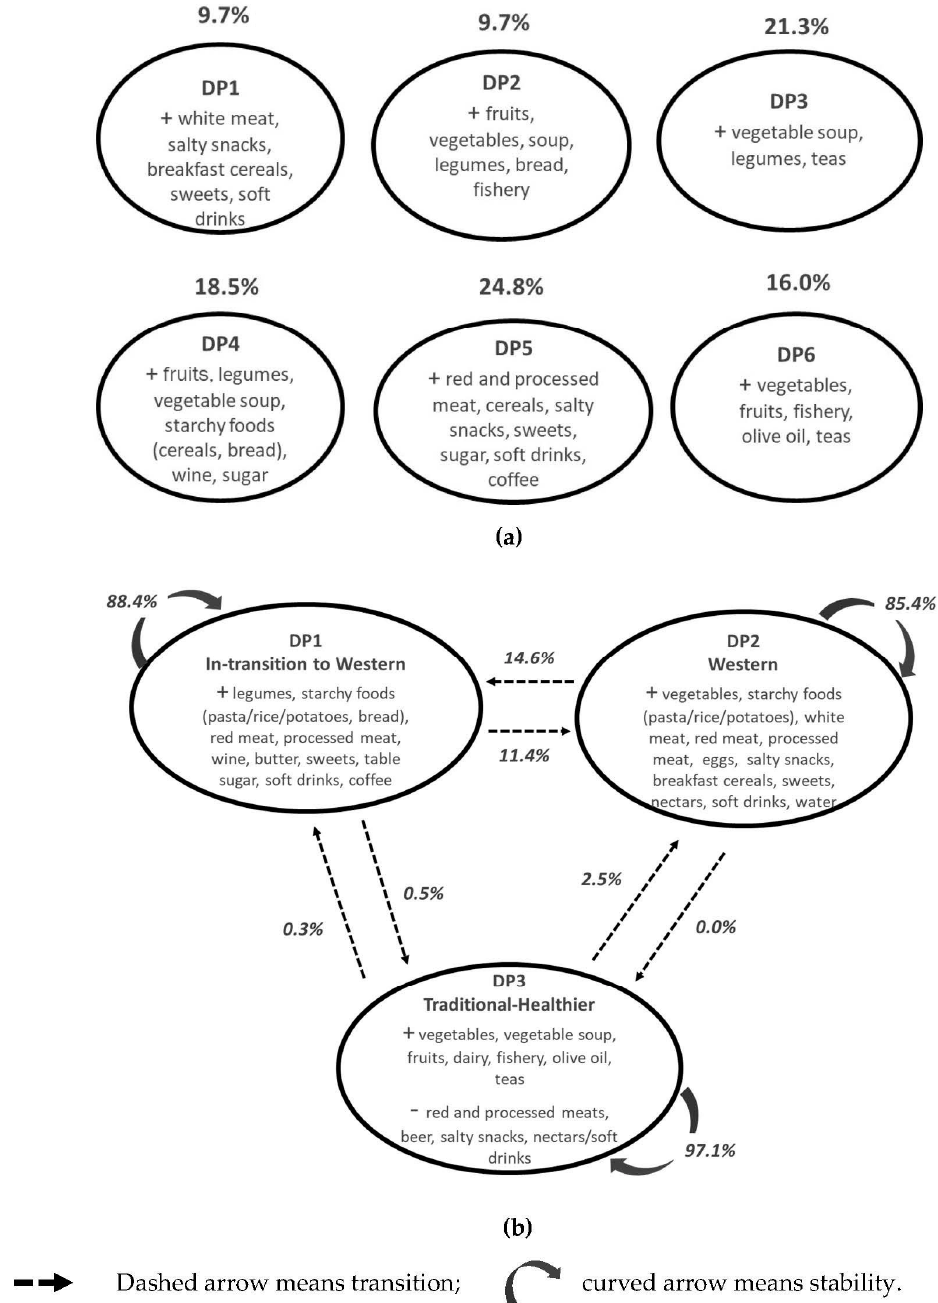
Figure 1. Description of dietary patterns: ( a ) latent class model (with concomitant variables); ( b ) latent transition model (with concomitant variables). Percentages (%) are the latent class probabilities (1a) or the latent transition probabilities (1b) based on the estimated model; food group descriptions are made based on the highest (+) and lowest intake (-) of major food